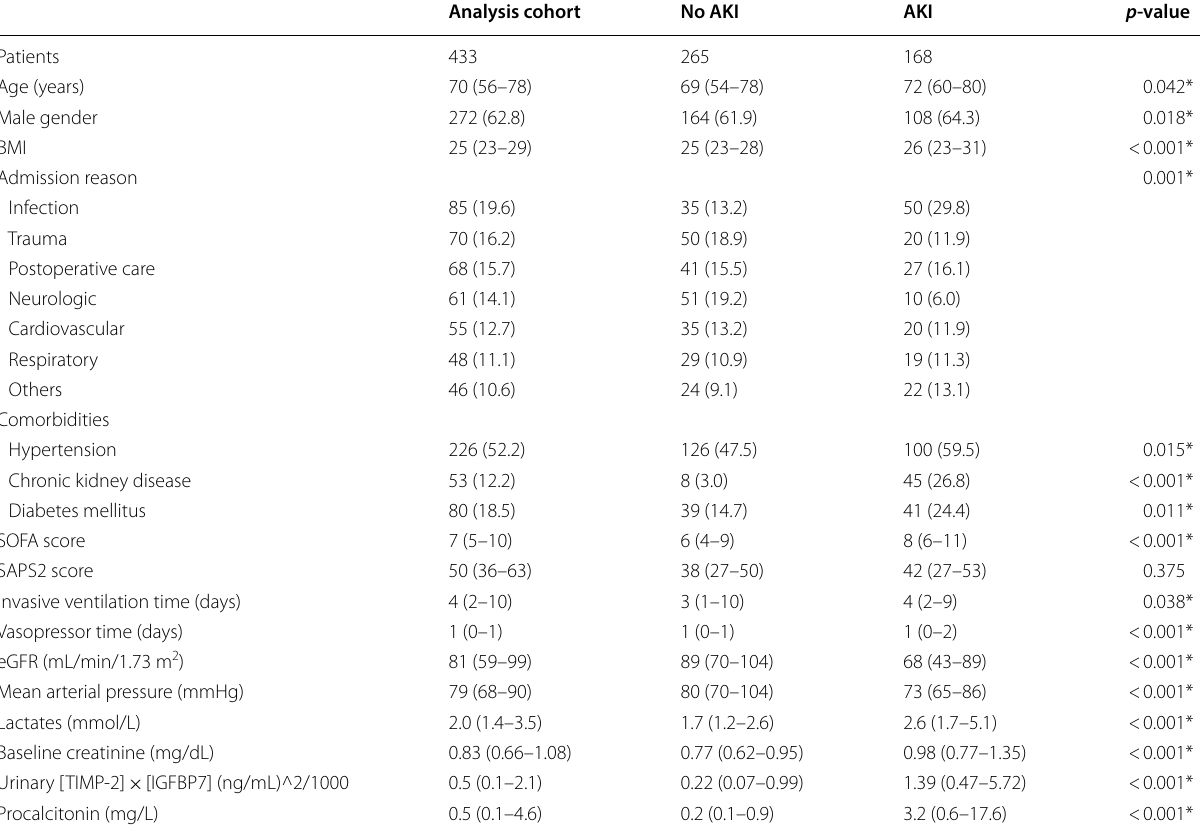
Table 1 Demographic data and admission